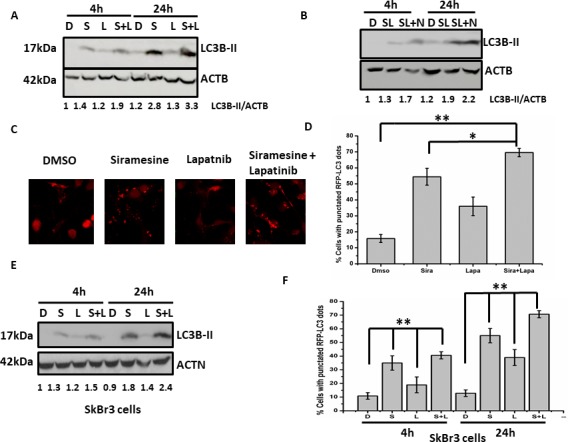
Autophagy flux increases following treatment of cells with siramesine and lapatinib.(A, B) Western blot determination of autophagy protein LC3-II in the absence and presence of NH4Cl when MDA MB 231 cells were treated with siramesine and lapatinib for 4and 24 hours. Actin (beta-actin) was used as a loading control (and same hereafter). (C, D) Autophagy was measured by quantifying the number of puncta of a fusion protein of red fluorescent protein LC3 (mRFP-LC3) per cell in MDA MB 231 cells. (E) Western blot determination of autophagy protein LC3-II when SKBR3 cells were treated with siramesine and lapatinib for 4 and 24 hours. (F) Autophagy was measured by quantifying the number of puncta of a fusion protein of red fluorescent protein LC3 (mRFP-LC3) per cell in SKBR3 cells. *p<0.05; **p<0.01.